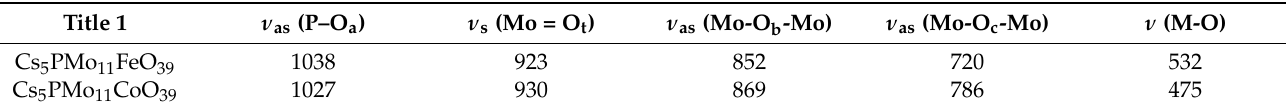
Figure 2. IR spectra of Cs 5 PMo 11 FeO 39 and Cs 5 PMo 11 CoO 39 . Table 2. IR frequencies (cm − 1 ) of Cs 5 PMo 11 FeO 39 and Cs 5 PMo 11 CoO 39.